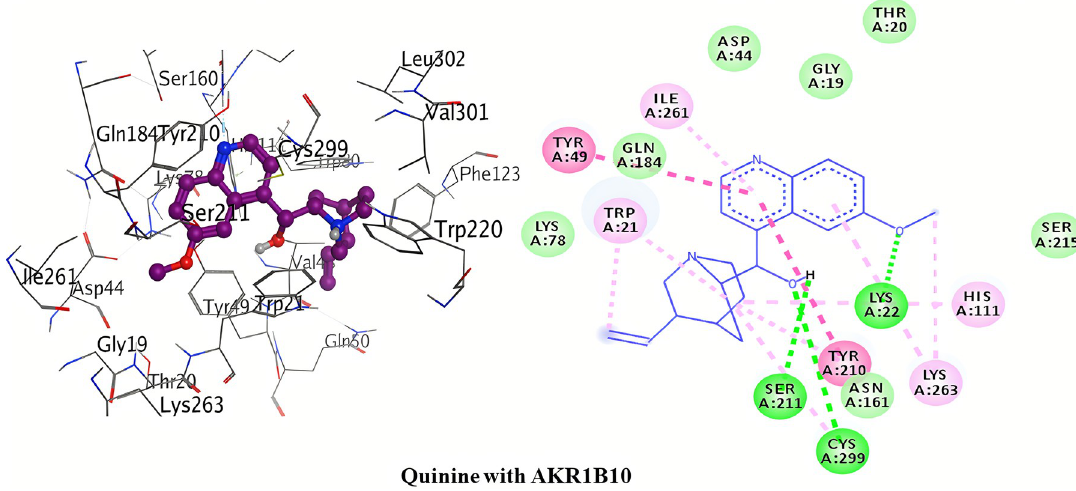
Fig 9. 3D and 2D interactions of quinine with active site of AKR1B10.